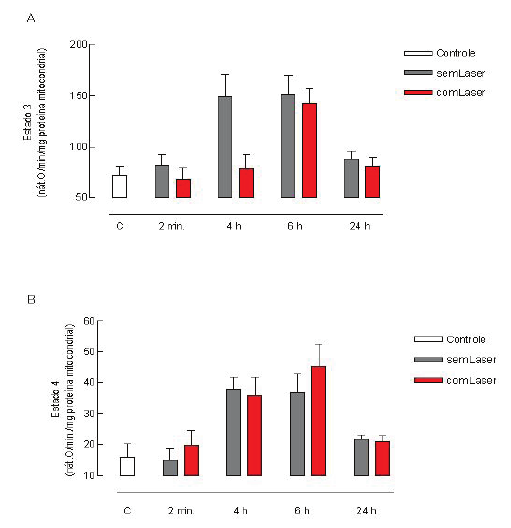
FIGURE 1 – Analysis of mitochondrial bioenergetic before PH (C: control) and after PH (2 min, 4h, 6h, 24 h), in the presence and absence of laser biostimulation. Panels A and B : mitochondrial respiration rates (state 3 and 4, respectively).